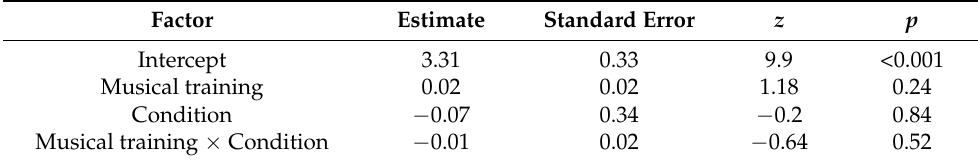
Table 2. Estimates for mixed model on switch costs (dependent variable: error data).